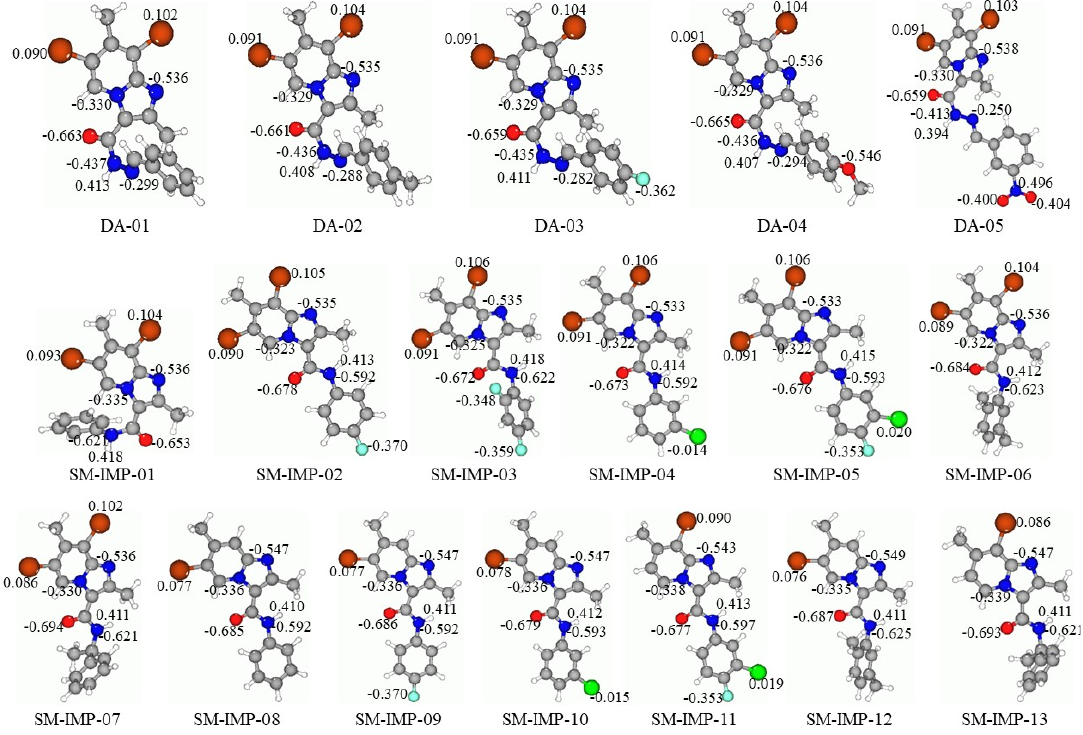
Figure 2. NPA charges, e, of selected atoms of the two series of the investigated compounds, B3LYP/6-311+G(d,p), computed with implicit effects from water.